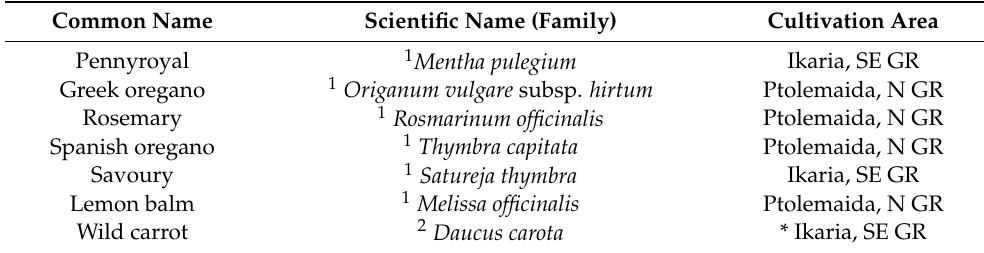
Table 4. Greek native medicinal-aromatic plant species used for the extraction of the examined essential oils and origin of the original plant